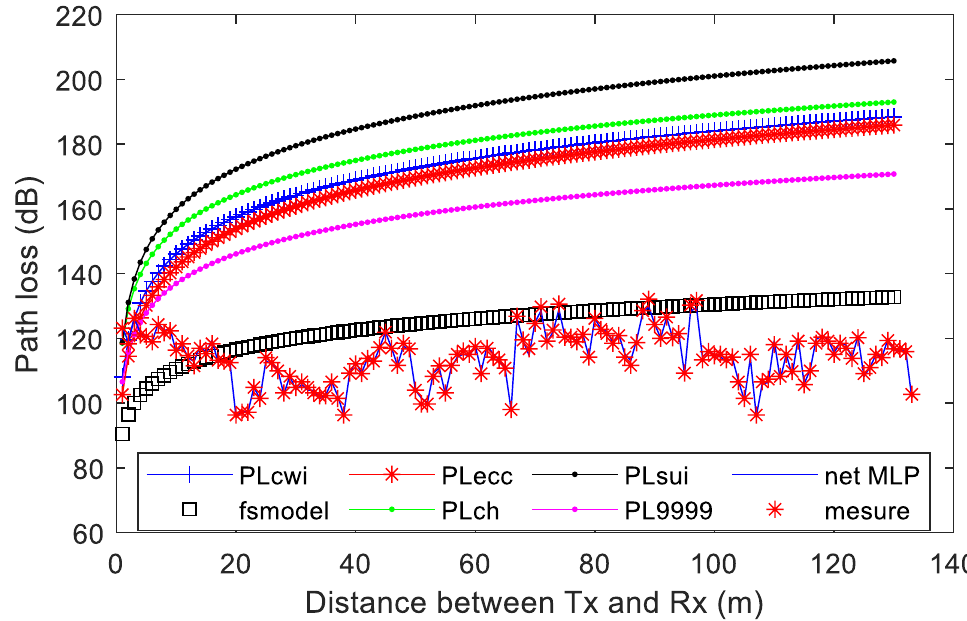
Figure 13. Comparison between empirical models and MLP (with one hidden layer) for Dataset 7.